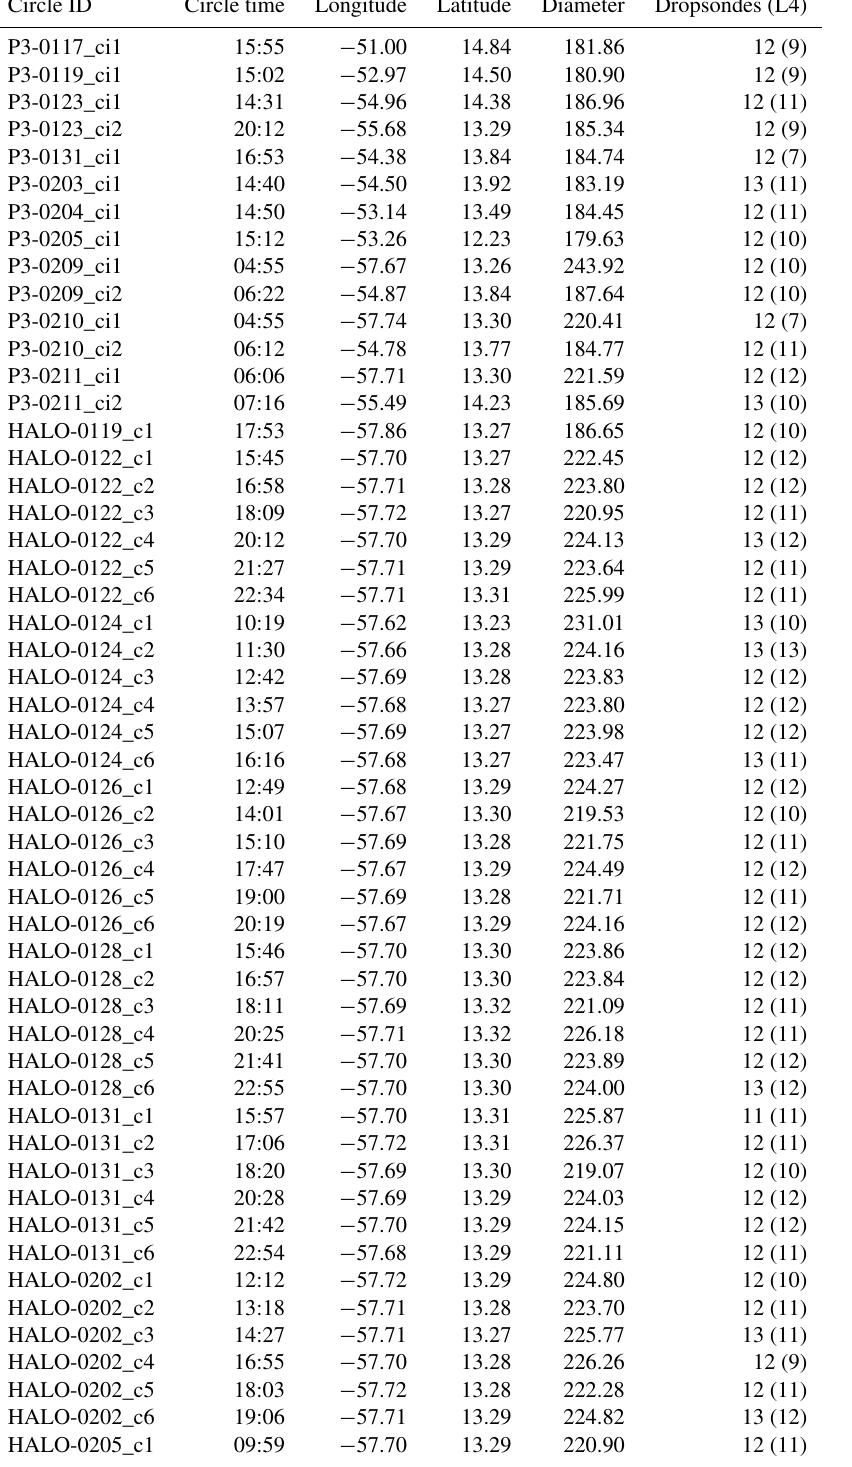
Table 3. Details of circles flown during EUREC 4 A. Circle time (in UTC) is the mean launch time for all sondes in the circle. Longitude ( ◦ E), latitude ( ◦ N) and diameter (km) are those associated with the center of a least-squares fitted circle to all sondes. Dropsondes show the total number of sondes launched in each circle. The numbers in parentheses (L4) show the number of good sondes (explained in Sect. 3) used for regression in Level